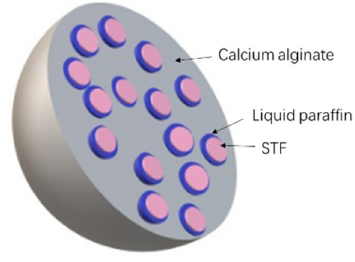
Figure 2. Schematic cross-section of STF capsule.